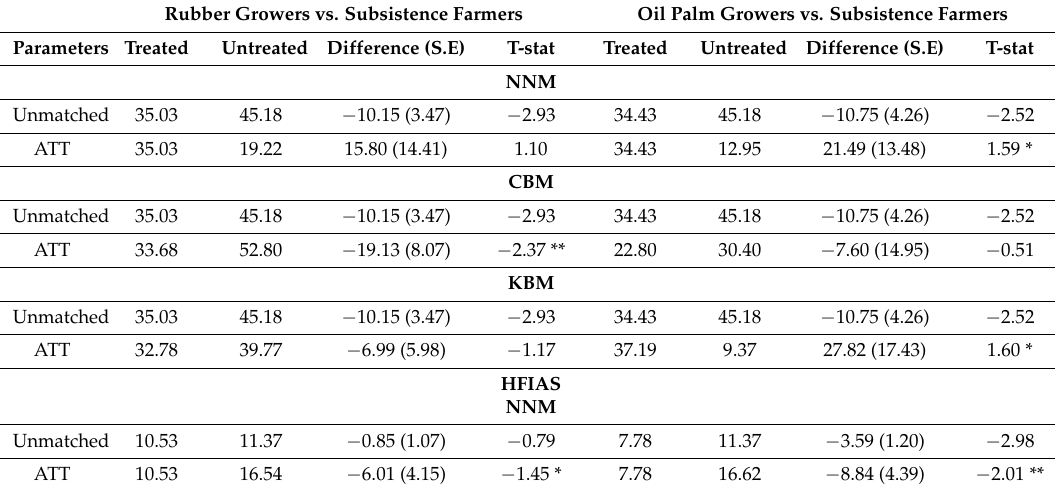
Table 4. Impact of participation in industrial crop production on food security metrics. Rubber Growers vs. Subsistence